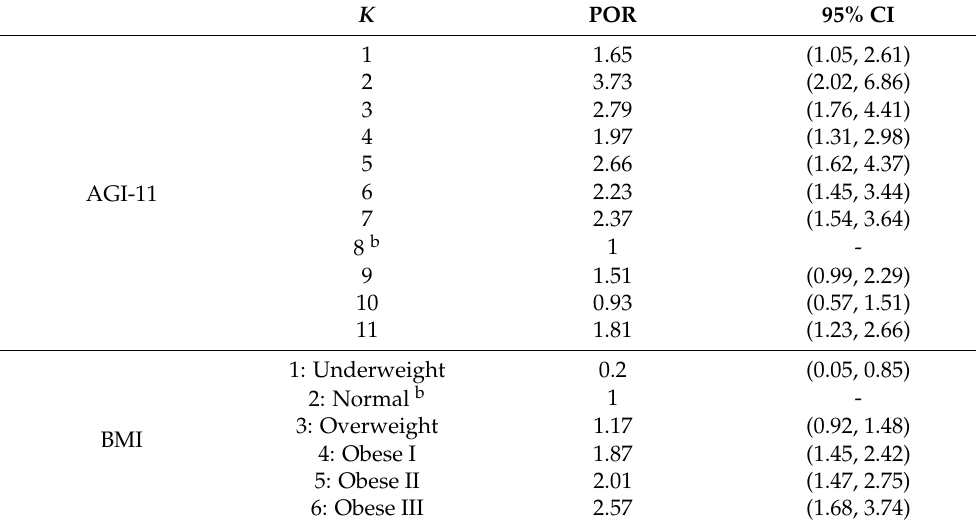
Table 3. Prevalence odds ratios a and 95% confidence intervals for AGI-11 and BMI to predict reported elevated sugar levels.